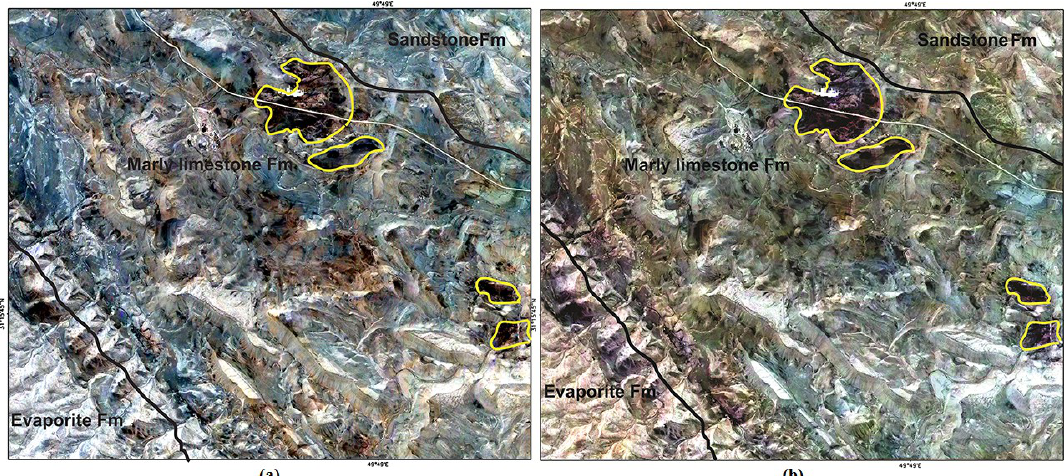
Figure 6. ( a ) False colour composite created from pan-sharpened ASTER VNIR bands (15-m resolution) with the WV-2 0.5-m panchromatic image; ( b ) false colour composite created from ASTER SWIR bands with the WV-2 0.5-m panchromatic image. The band combination used in (a) is (RGB) 1-2-3 and in (b) is (RGB) 4-6-8. Yellow polygons show alteration zones enhanced by fusion (the extension of this image is shown as a black box in Figure